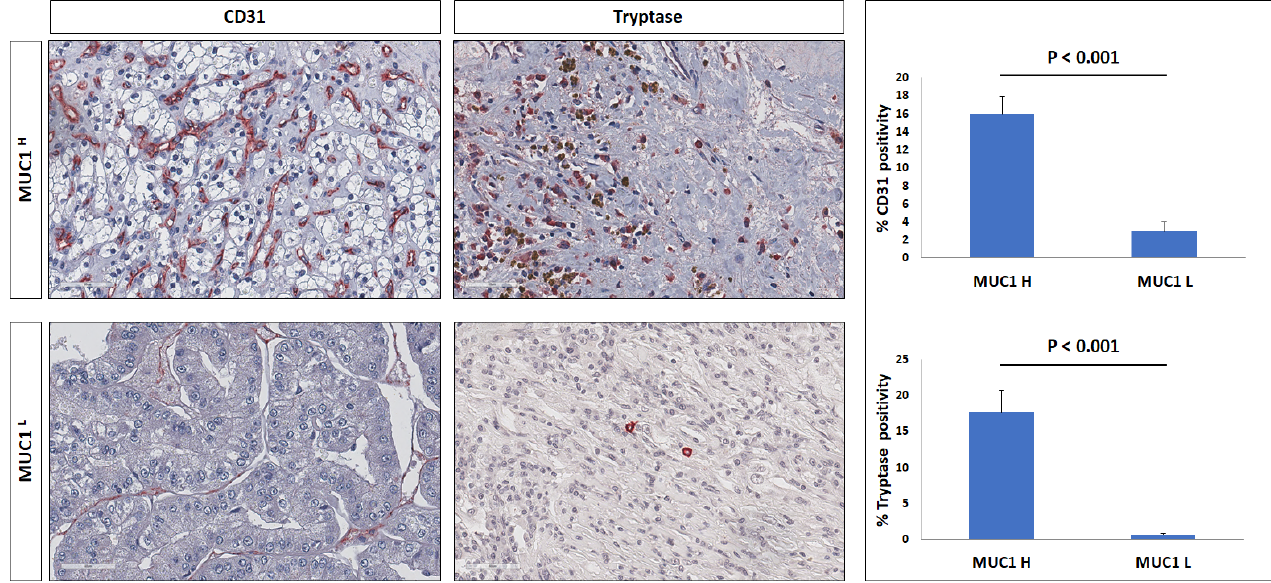
Figure 7. Immunohistochemical staining of CD31 microvessels and tryptase in MUC1 H ccRCC as compared with MUC1 L tumor.